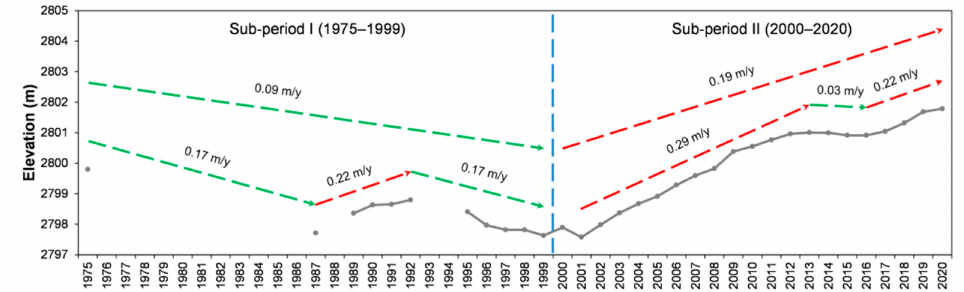
Figure 12. Interannual variation in the water level of Gahai